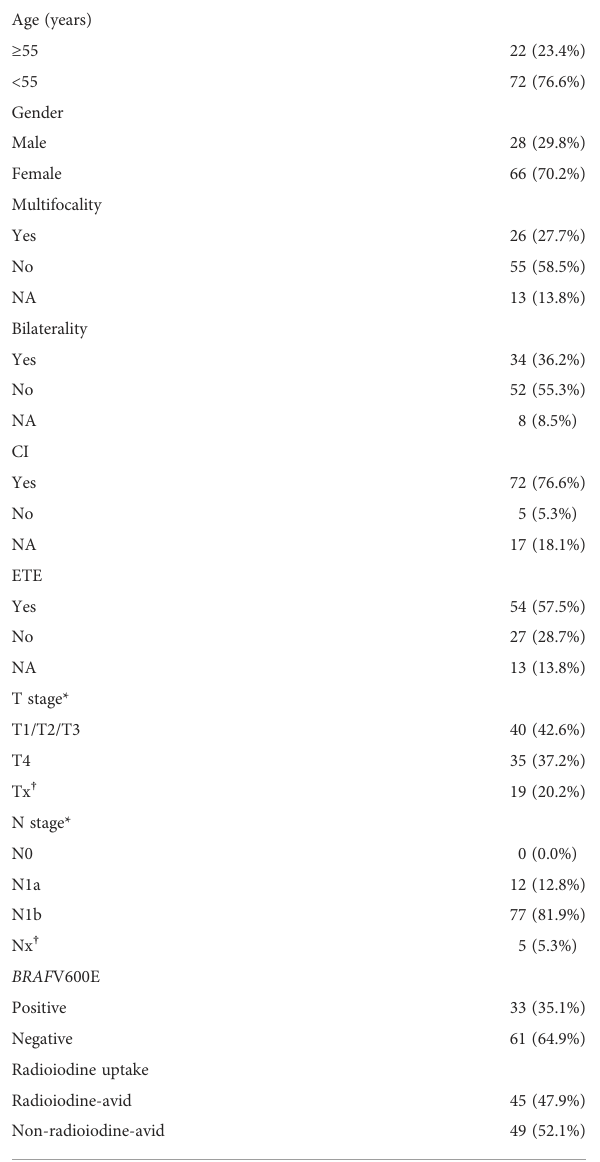
TABLE 1 Clinical characteristics of all